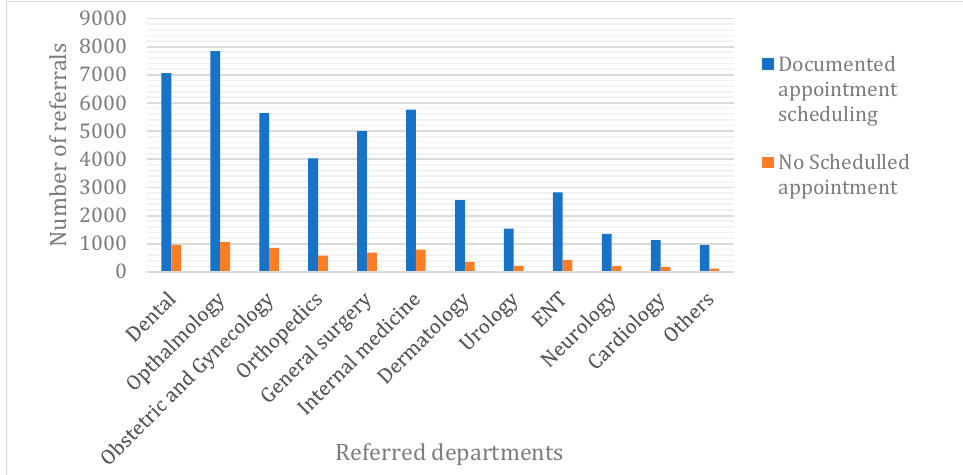
Figure 4. Distribution of referrals outcomes per department between 2019 and 2021 ( n = 52,143).